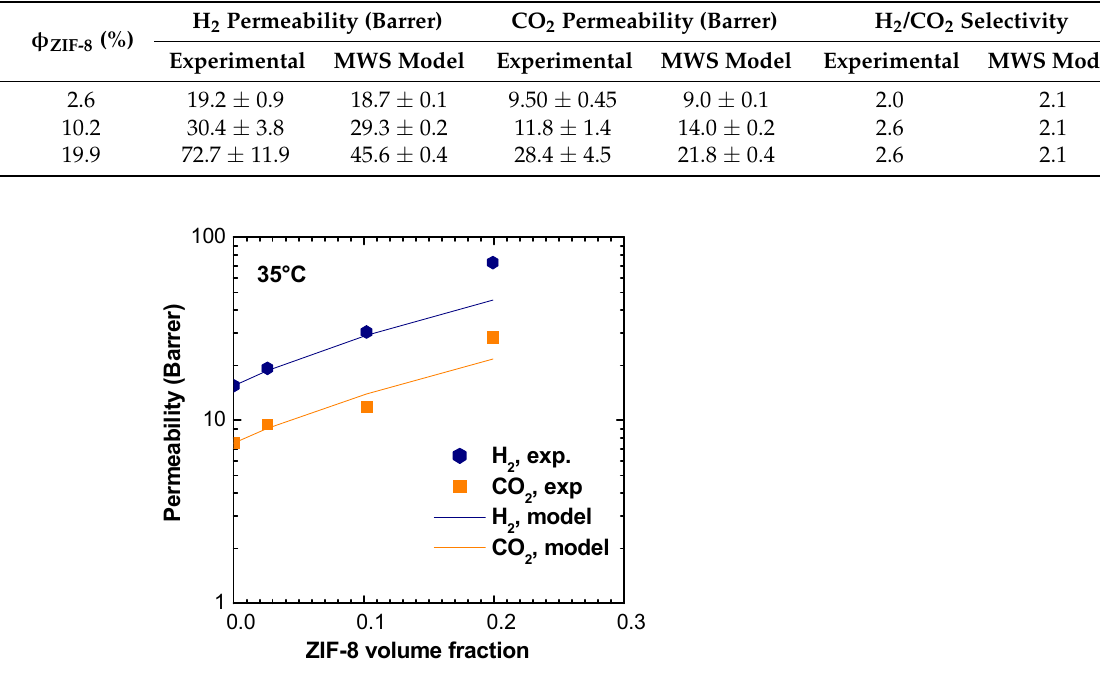
Figure 17. H 2 , CO 2 permeabilities obtained with MWS model for PSf/ZIF-8 MMMs.